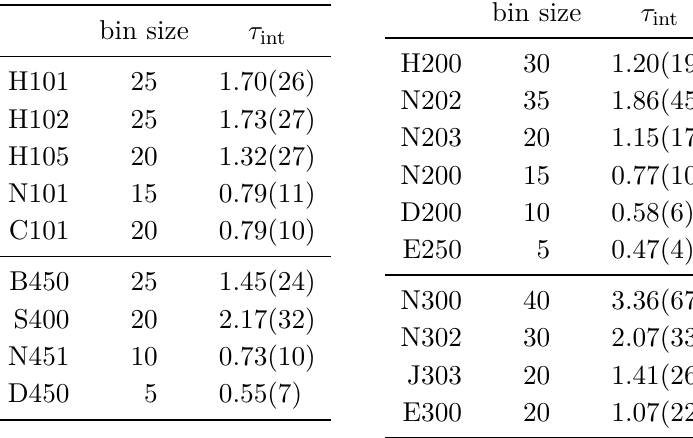
Table 10 . Bin size and integrated autocorrelation time in units of saved configurations for each of the ensembles included in our study. Configurations are saved every 4 molecular dynamics units (MDUs) (2 trajectories of length 2 MDUs), except for J303, for which configurations are separated by 8 MDUs (4